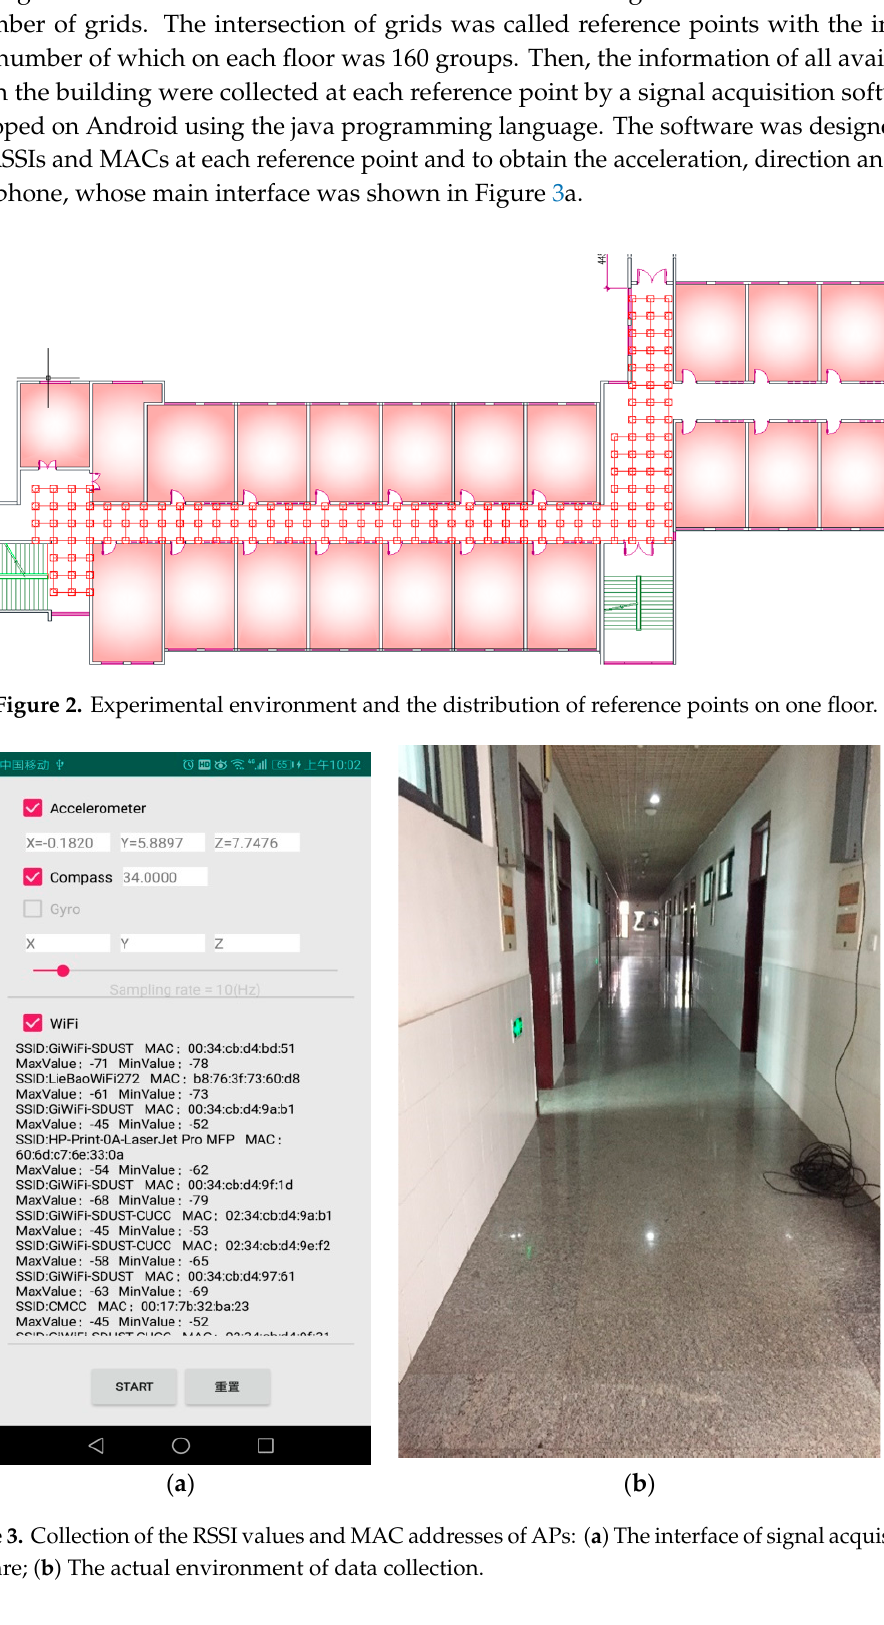
( b ) Figure 3. Collection of the RSSI values and MAC addresses of APs: ( a ) The interface of signal acquisition software; ( b ) The actual environment of data collection.